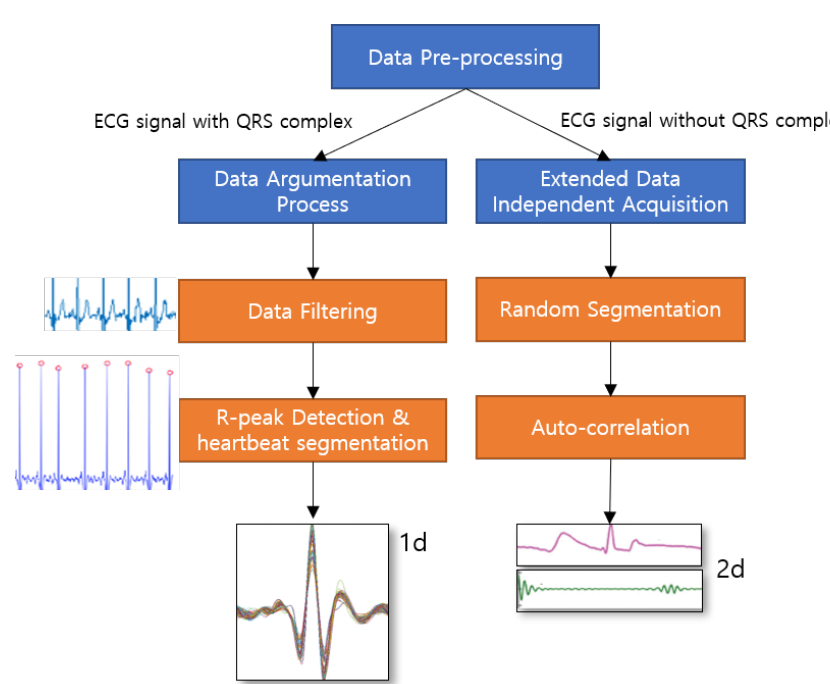
Figure 4. A framework of data preprocessing phase to carry out the proposed models according to respective datasets.